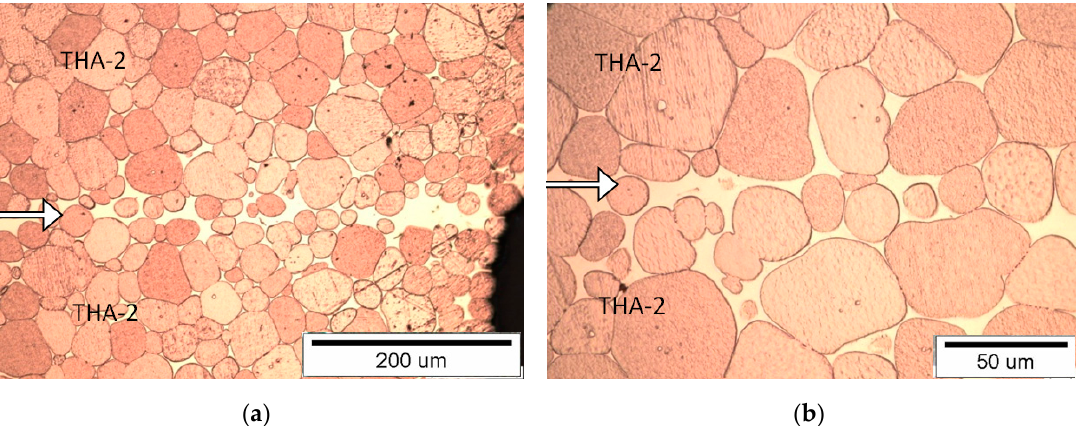
Figure 4. View of the microstructure of the THA-2 with THA-2 at a magnification of 200 × ( a ) and 500 × ( b ), (the connection line (joint) is shown by the arrow).